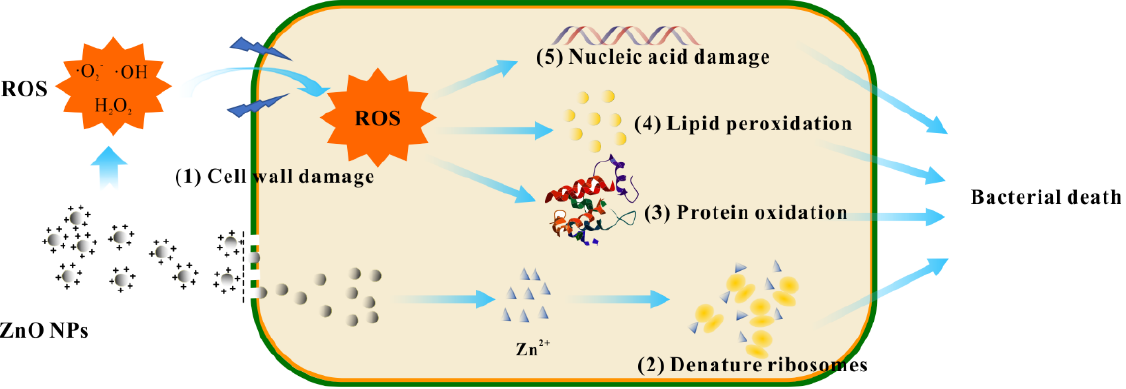
Figure 6. The antibacterial mechanism diagram of cellulose composite hydrogel loaded with ZnONPs.